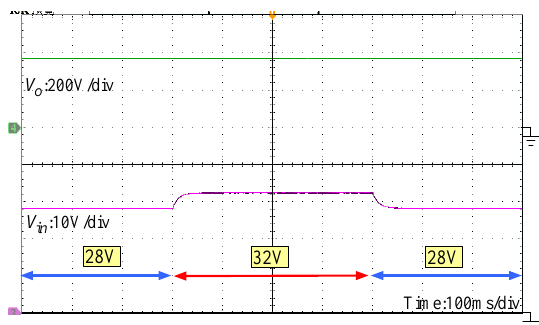
Figure 17. Dynamic response of output voltage under step load variation.